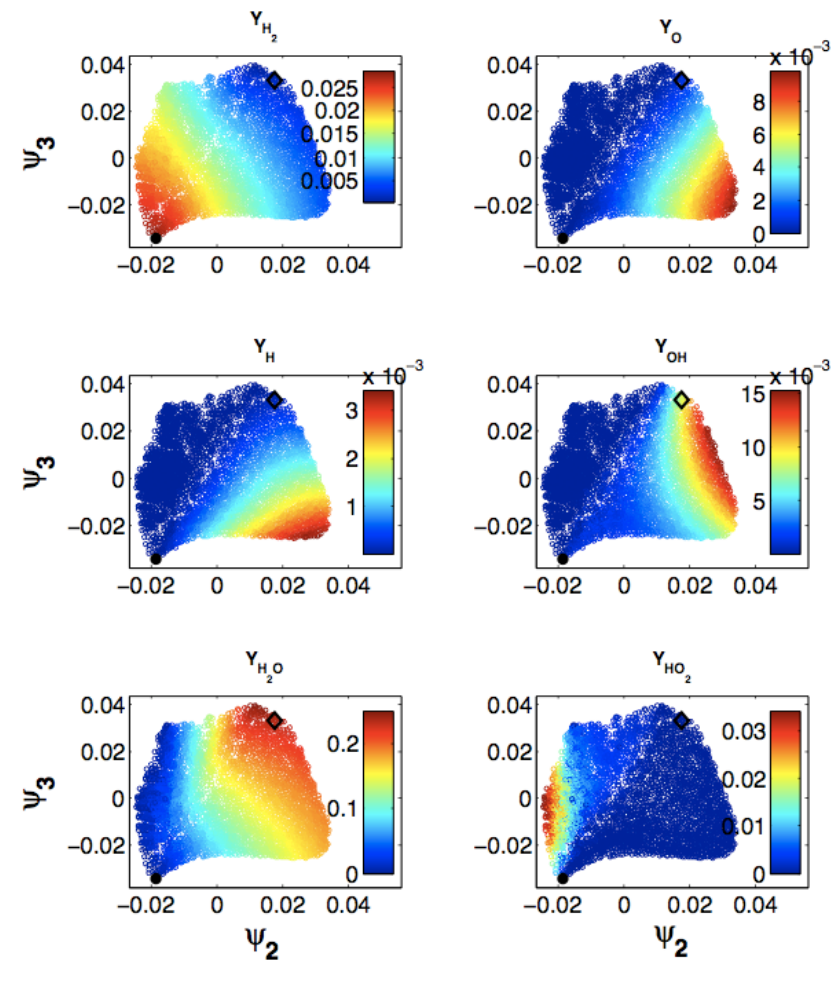
Figure 9. Homogeneous reactive mixture of hydrogen and air at stoichiometric proportions with fixed enthalpy ( H = 300[ kJ/kg ] ) and pressure ( P = 1[ bar ] ). Two dimensional Diffusion Map (DMAP) parameterization of 3810 points in terms of the two nontrivial leading eigenvectors, ψ and ψ , of the Markov matrix, K . Colors represent mass fractions, 2 3 while the black filled circle and the black diamond represent the fresh mixture condition and equilibrium state,